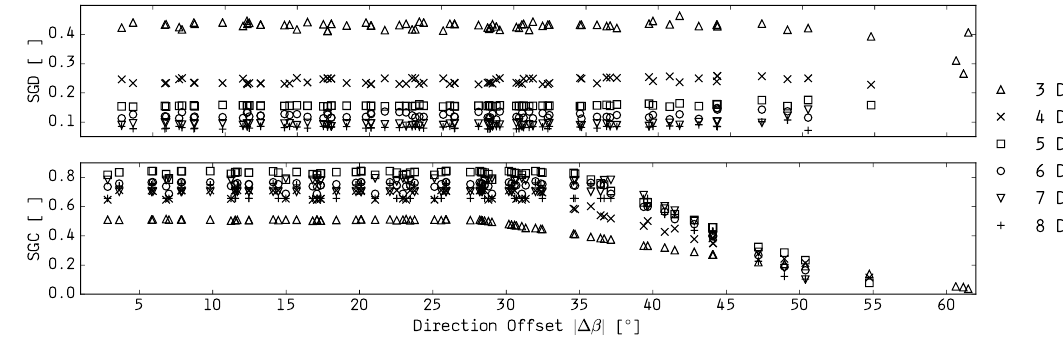
Figure 4. Scanning geometry density ( SGD , top ) and coverage ( SGC , bottom ) indices calculated for vertical planes at discrete downstream distances of the turbine from 3 D–8 D, as a function of the absolute value of the wind direction offset ( | ∆ β | = scanning geometry described in the